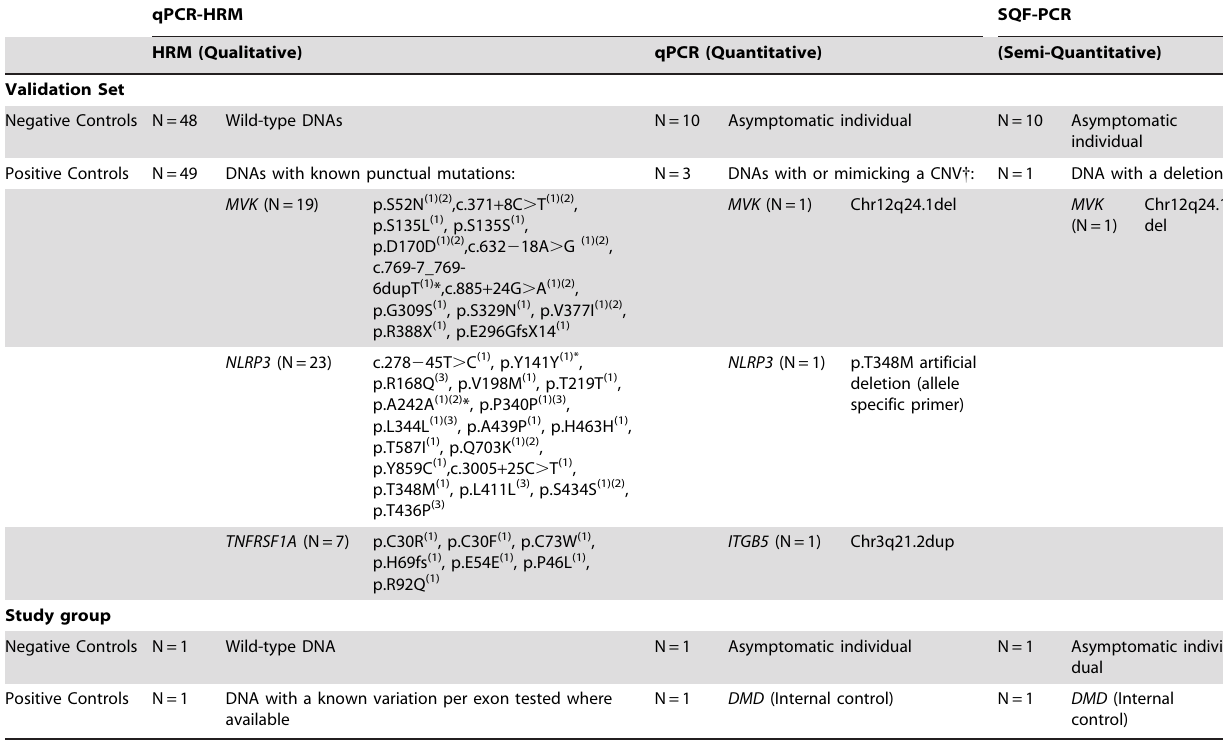
Table 2. Controls used in this